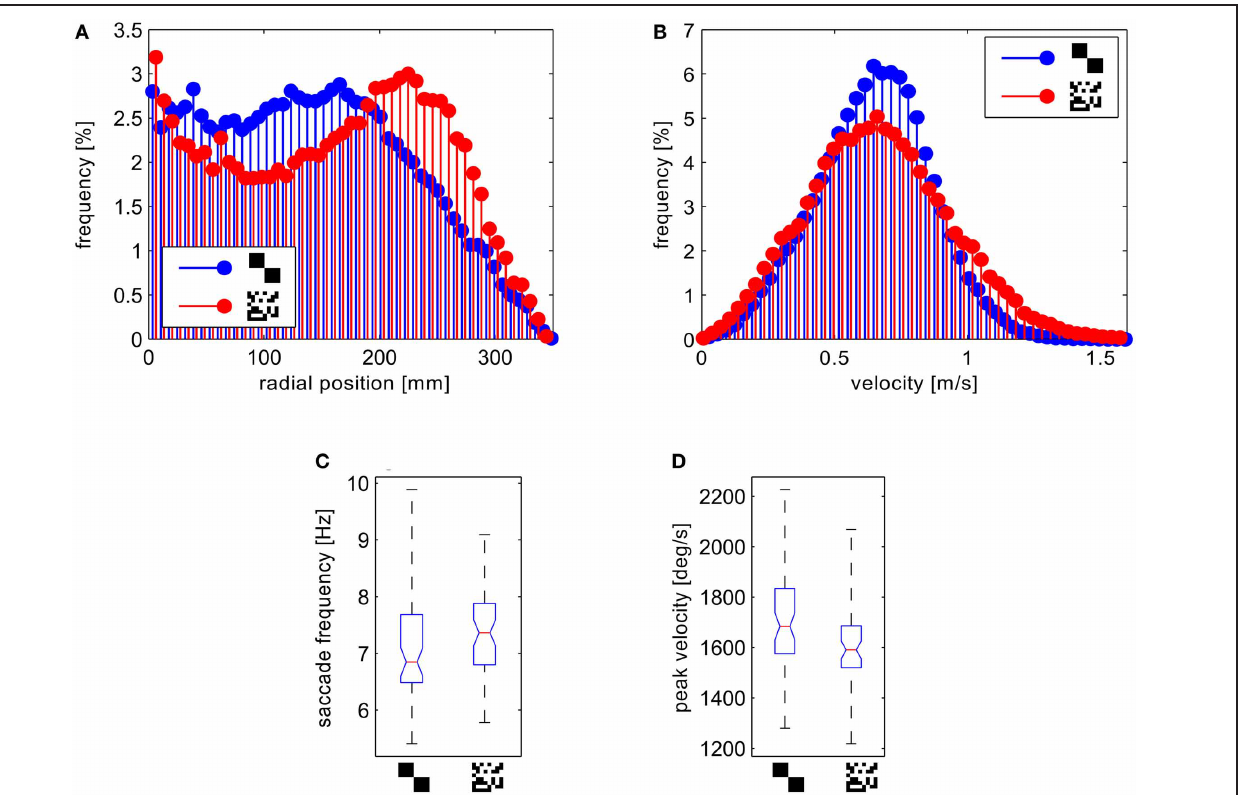
FIGURE 8 | Analysis of the behavioral data. (A) Histograms of the distance of the fly position from the center normalized to the circumfence of each circular bin. (B) Histograms of the forward velocities. (C) Boxplots of the